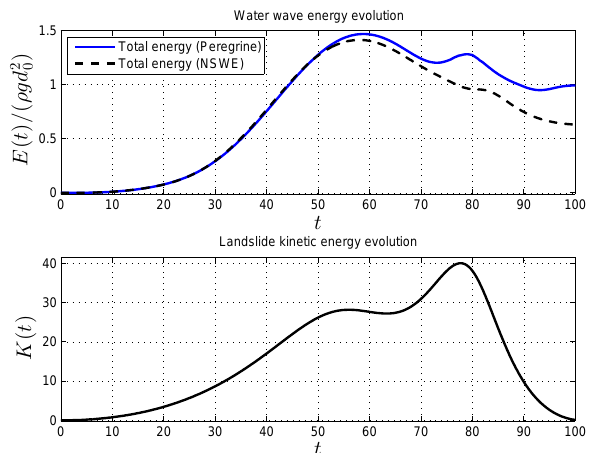
Fig. 15. Run-up on the left and right beach using Eq. (19), computed Figure 15. Run-up on the left and right beach using (6.4) , computed with the Fig. 14. Development of the wave energy, and the kinetic energy of with the dispersive system (solid curve) and the nonlinear shallow- Figure 14. Development of the wave energy, and the kinetic energy of the land- dispersive system (solid curve) and the nonlinear shallow-water sys- the landslide as a function of (non-dimensional) time. Note that the water system (dashed curve) as a function of (non-dimensional) slide as a function of (non-dimensional) time. Note that the kinetic kinetic energy of the landslide starts from 0 (all energy is potential) tem (dashed curve) as a function of (non-dimensional) time. energy of the landslide starts from 0 (all energy is potential) and and also ends at 0 (all energy has been dissipated or transferred to also ends at 0 (all energy has been dissipated or transferred to the the fluid). fluid).